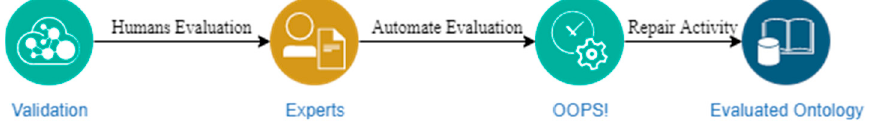
Figure 1. The proposed validation procedure.